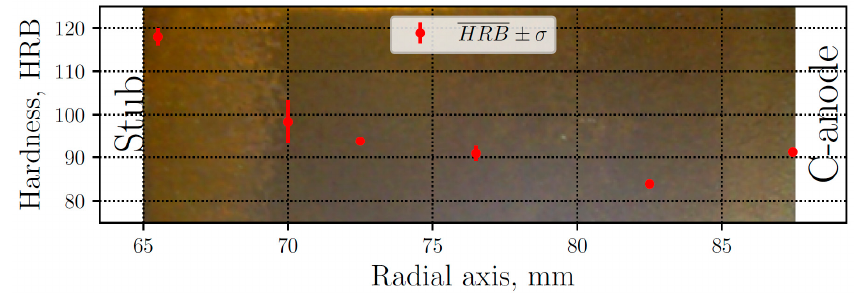
Figure 3. Measured mean hardness ( HRB ) and standard deviation ( σ ) along radial axis. Macrograph of a polished sample of the thimble